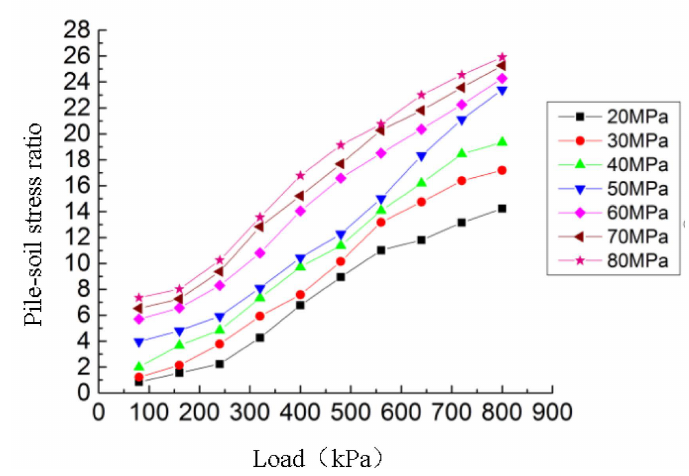
Figure 21. The elastic modulus of the cushion e ff ect on the pile-soil